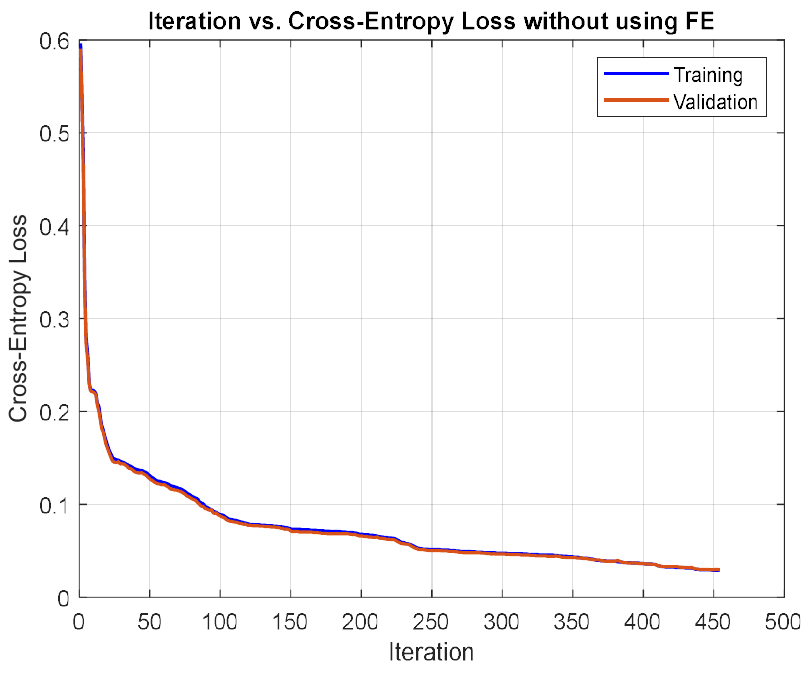
Figure 3. Iteration vs. cross-entropy loss for noisy signals with length 1600, and one hidden layer with ten nodes for DNN.